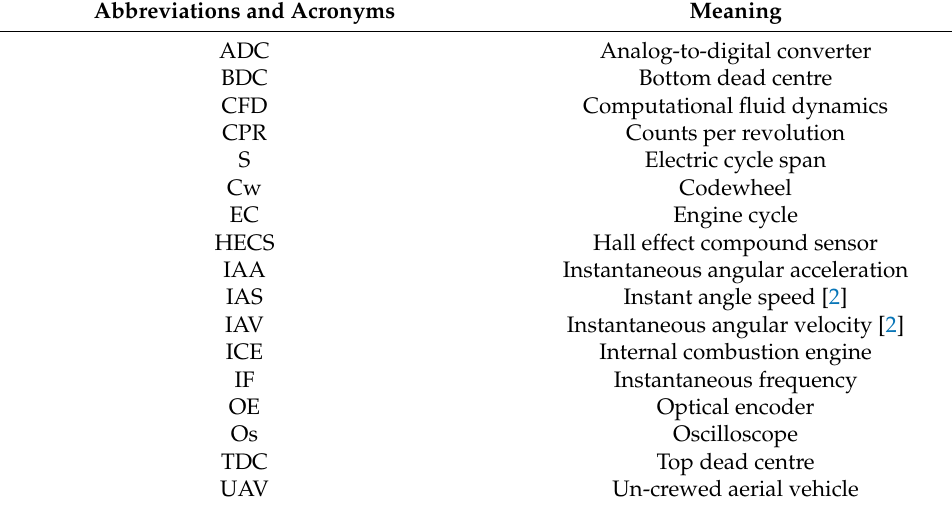
Table 1. Abbreviations. Abbreviations and